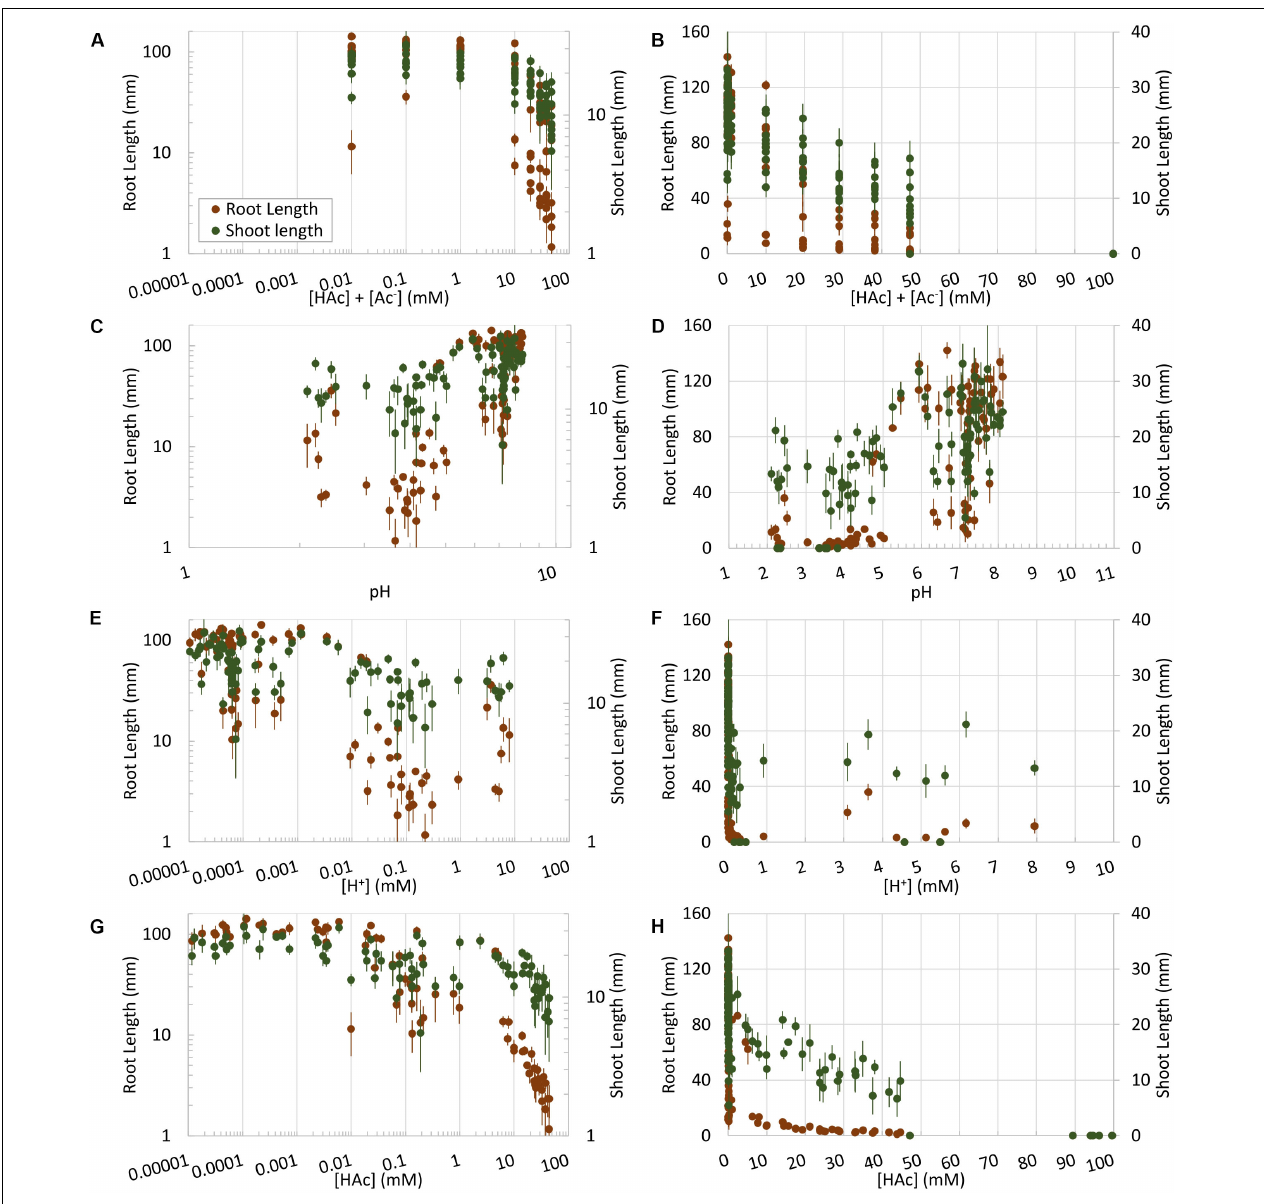
FIGURE 3 | Undissociated acetic acid ([HAc]) (G,H) impacts on root and shoot growth on germination paper, along with total acetic acid ([HAc] + [Ac − ]) (A,B) or acidity expressed as [H + ] (E,F) or pH (C,D) . Mean root and shoot data ( ± 1 standard error; n = 6) are plotted both on logarithmic (A,C,E,G) and linear (B,D,F,H)